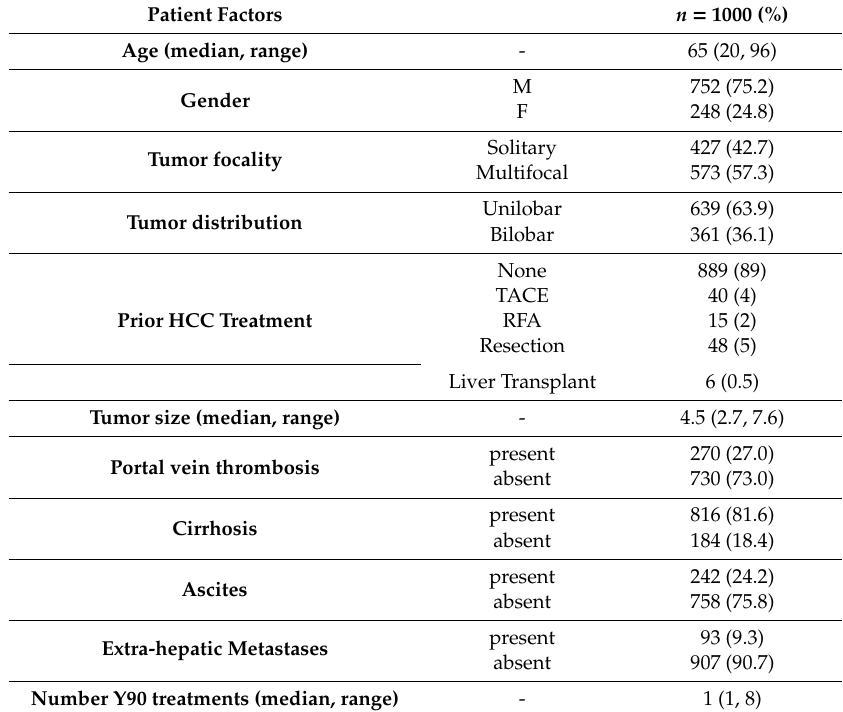
Table 1. Baseline Patient